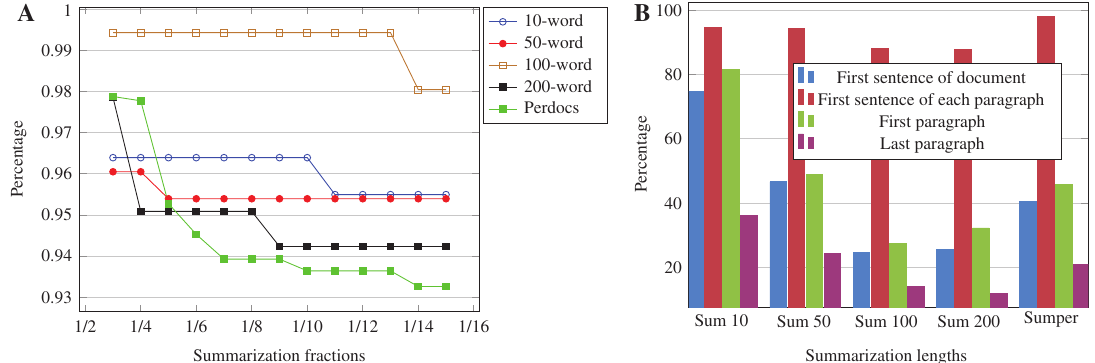
Figure 2: The plots of the obtained results described (A) Covering of the Salient Entities Mentioned in the Documents. (B) Percentage of Mentioned Salient Entities in the Sections of DUC